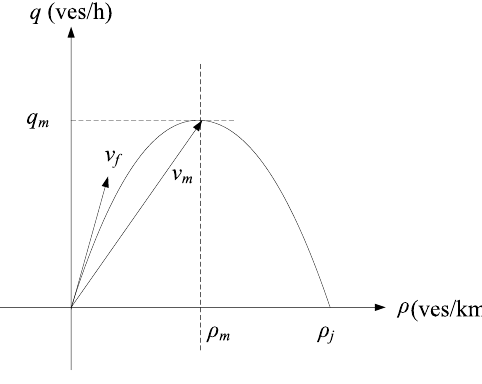
Fig. 2 The relationship between traffic flow rate and